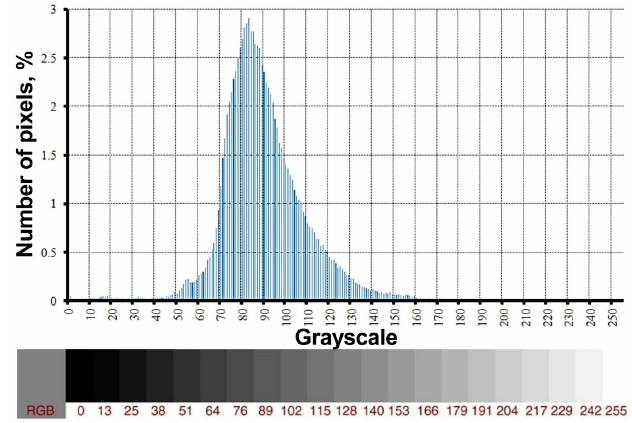
Figure 3. Distribution of the X-ray absorption coefficient in a form of grayscale values in the sample section obtained by the method of X-ray tomography.